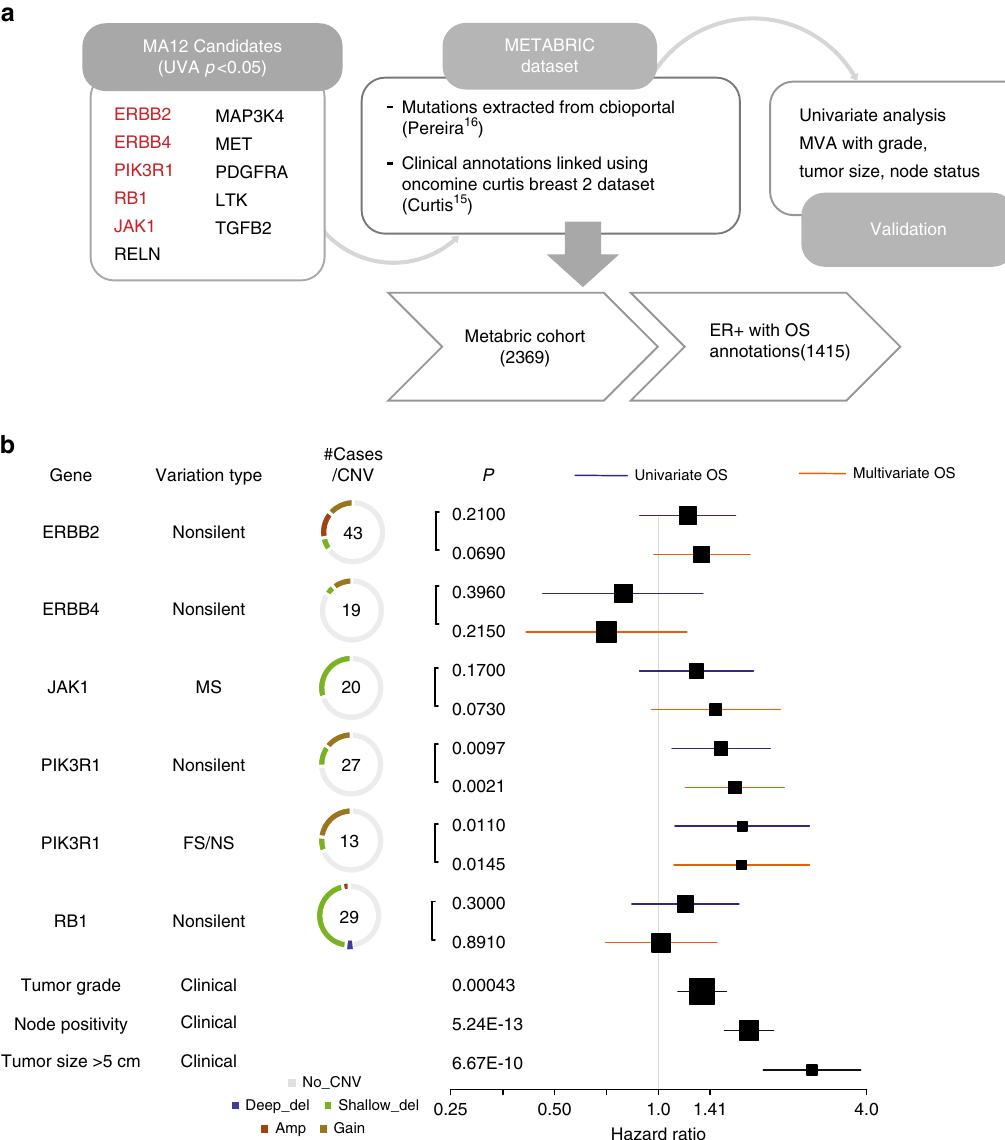
Fig. 6 Validation of MA12 candidates in ER + METABRIC. a Five out of eleven candidates from MA12 analysis had mutations reported in the METABRIC cohort. 1415 ER + samples with overall survival information were used to test the effect of mutations in the candidate genes on prognosis. b Forest plot shows effect of mutated candidate genes, shortlisted based on MA12 mutation analysis, on overall survival in METABRIC ER + breast cancer patients. Univariate (blue) and multivariate (orange) cox proportional-hazard ratios depict the independent prediction of survival outcomes for the six candidate genes. The box size is relative to frequency of mutations in the analysis, with larger boxes representing higher incidence mutations. The # cases/CNV column shows the total number of cases with the SNV/Indel variant surrounded by a ring chart indicating the proportion of total cases with CNV alterations Log-rank test was used to determine signi fi cance and Cox regression proportional hazards generated univariate hazard ratios. Multivariate Cox proportional-hazard model was used in the multivariate